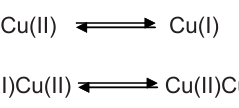
scan rate 150 mV s